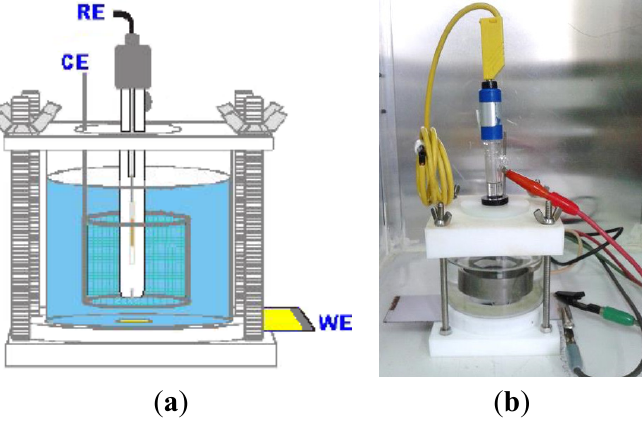
Figure 1. Sketch ( a ) and photograph ( b ) of the electrochemical cell employed in this